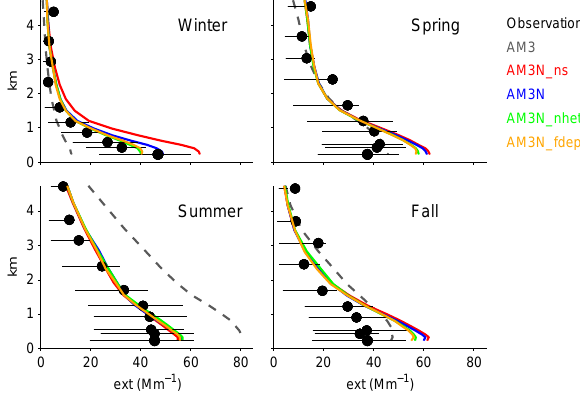
Figure 6. Mean seasonal observed (black dots) and simulated sur- face and vertical profiles of aerosol dry extinction at Bondville (40.1 ◦ N, 88.4 ◦ W). The vertical profile show the average of all ob- servations by the Airborne Aerosol Observatory from 2006 to 2009 collected during daytime (10:00–16:00 local time). Surface obser- vations reflect the average of all daytime observations at the ESRL BND station from 2006 to 2012 with no local pollution. The model is averaged for daytime from 2008 to 2010. Horizontal lines show the 25th to 75th percentiles of observed dry aerosol extinctions. Dry extinctions are reported at standard temperature and pressure (273.15K, 1atm). We multiply the modeled nitrate extinction by 0.8 to account for the evaporation of ammonium nitrate in the neph- elometer (Bergin et al., 1997). The different model sensitivity ex- Figure 5. Observed and simulated aerosol optical depth at 550nm periments are described in Table at Bondville (40.1 ◦ N, 88.4 ◦ W) in AM3 and AM3N_fdep_diu. Ob- servations (black crosses) are averaged from 2006 to 2012 and the thin vertical black bars denote 1 standard deviation of the mean. Thick color bars show the simulated optical depth of SO 2 − (red), 4 NO − (cyan), OC (green), BC (purple), dust (brown), and sea salt 3 (blue) for AM3N_fdep_diu (2008–2010 average).